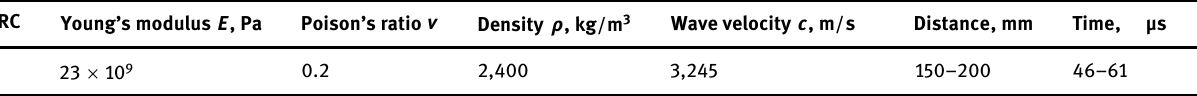
Table 3: Material constants and impact wave characteristics RC